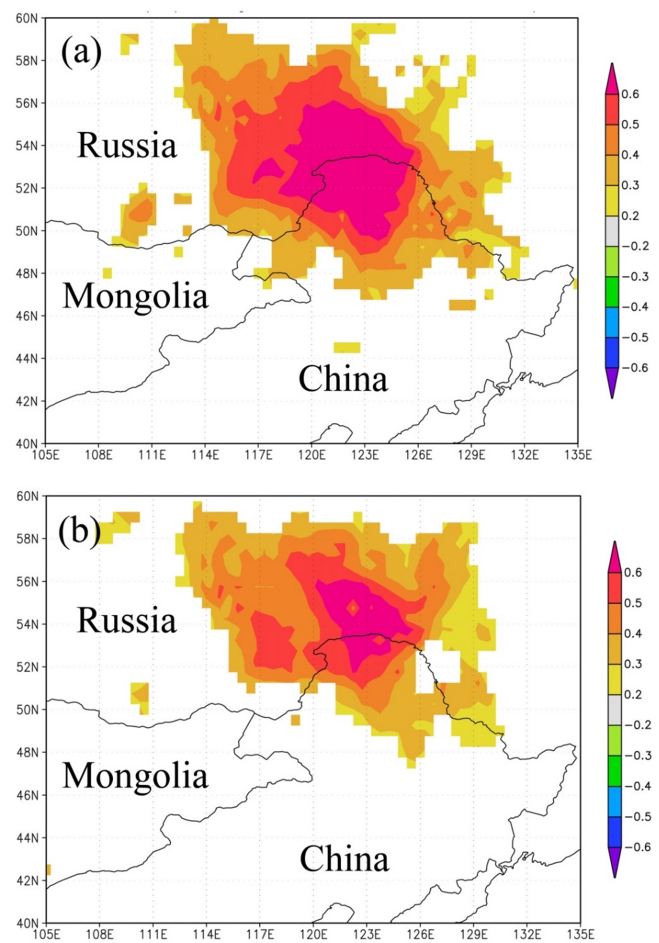
Figure 7. Spatial correlation patterns between ( a ) instrumental and ( b ) reconstructed PDSI p6-7 and the Climatic Research Unit (CRU) gridded PDSI for the period 1955–2016. Correlation analysis was performed using the KNMI climate